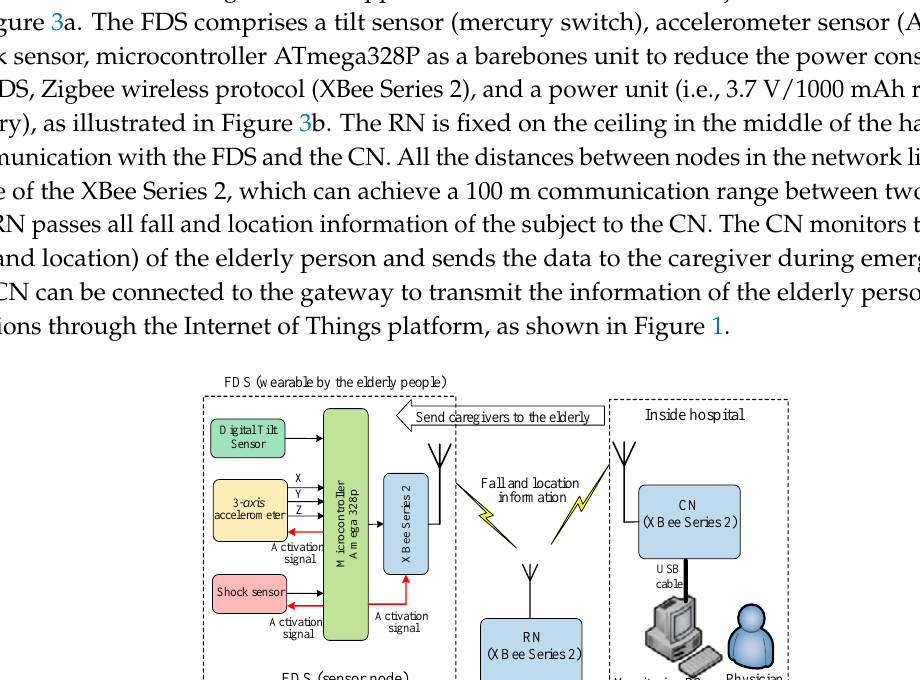
Figure 2. FDS architecture.